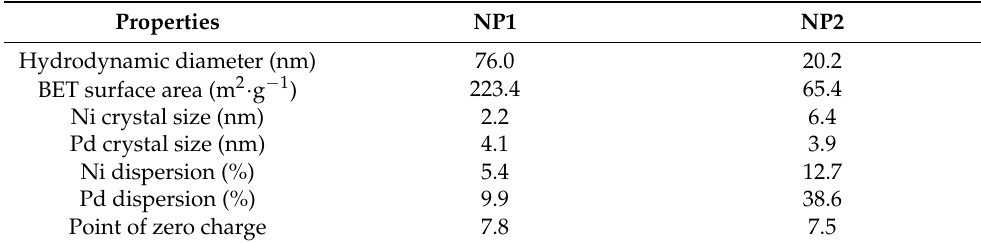
Table 3. Basic characteristic of nanoparticles.